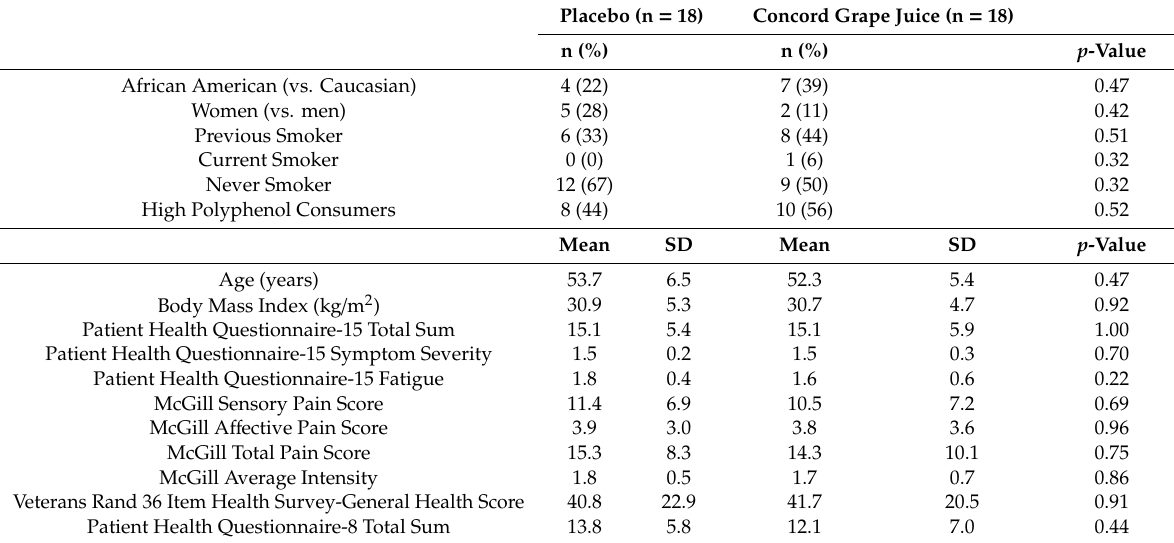
Table 2. Key baseline characteristics by randomization group.